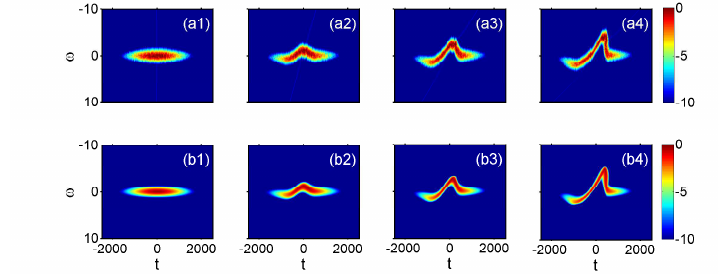
Figure 2. Phase-space representation of the shock-collapse singularity shown in Figure 1: ( a ) Numerical simulation of the NLS Equation (1) showing the evolution of the spectrogram. ( b ) Numerical simulation of the Vlasov Equation (2). Propagation lengths at z = 0,60,130,200 from left to right, τ R = 300, σ = −